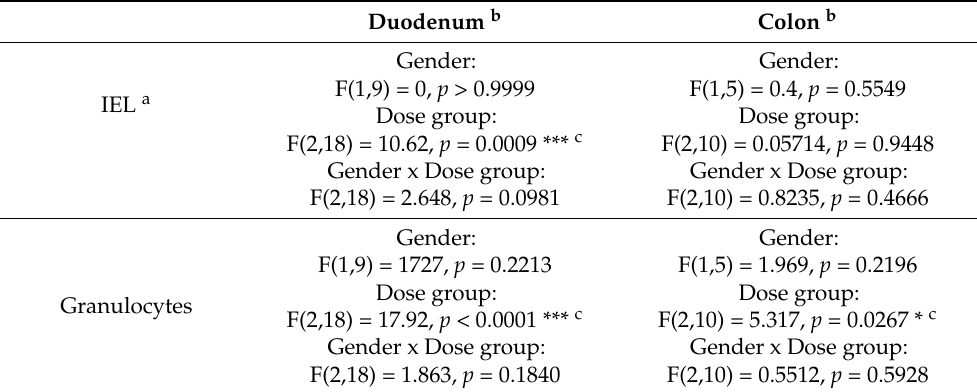
asterisk, and p ‐ value < 0.001 with three asterisks.